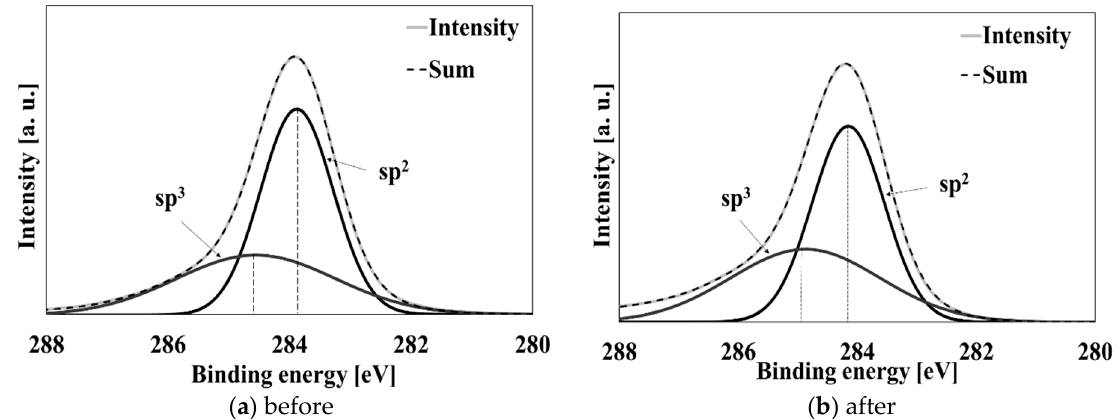
Figure 5. X-ray photoelectron spectroscopy (XPS) spectra for diamond-like coating (DLC)/SUS ( a ) before and ( b ) after the immersion and sterilization tests.